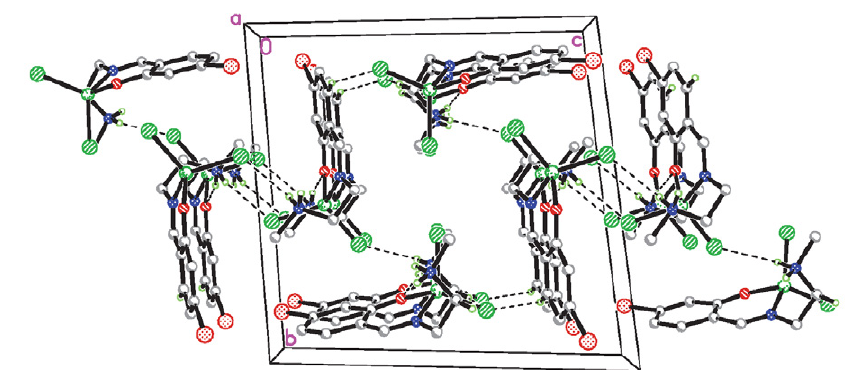
Fig. 6. Molecular packing diagram of complex 3 , viewed along the a axis. Hydrogen bonds are drawn as dashed